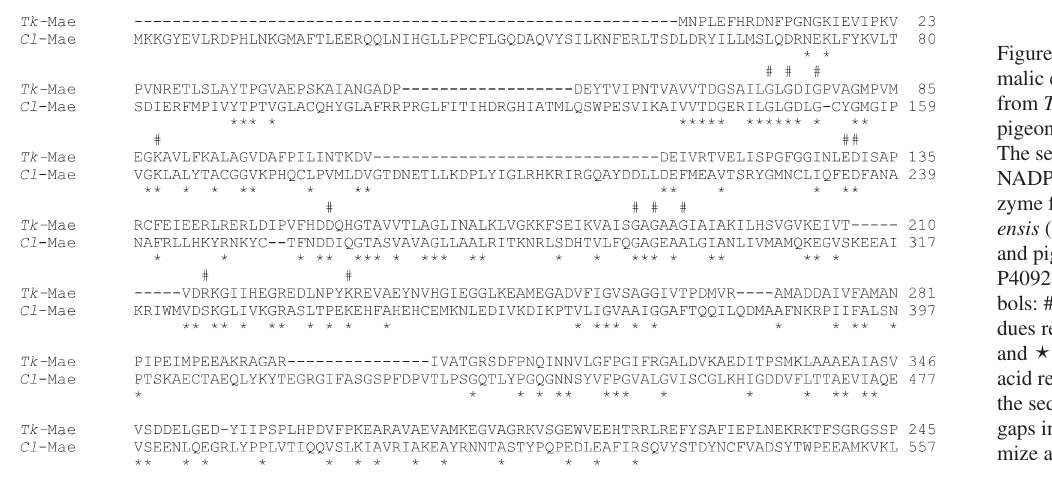
Figure 3. Alignment of malic enzyme sequences from T. kodakaraensis and pigeon ( Columba livia ).